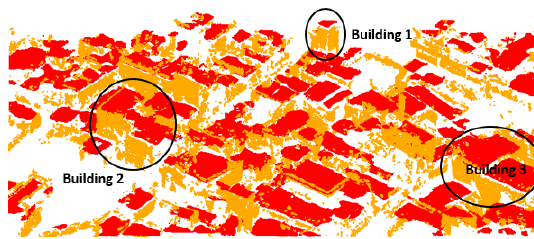
Figure 8: Buildings considered for accuracy assessment